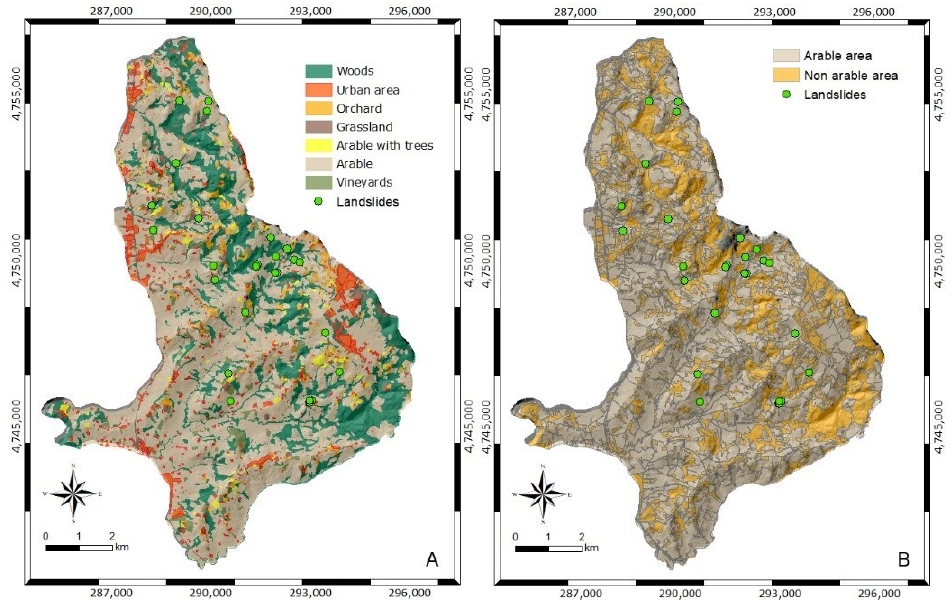
Figure 2. Maps showing ( A ) the distribution of land use and ( B ) a picture of the cultivated and uncultivated areas in the study area.